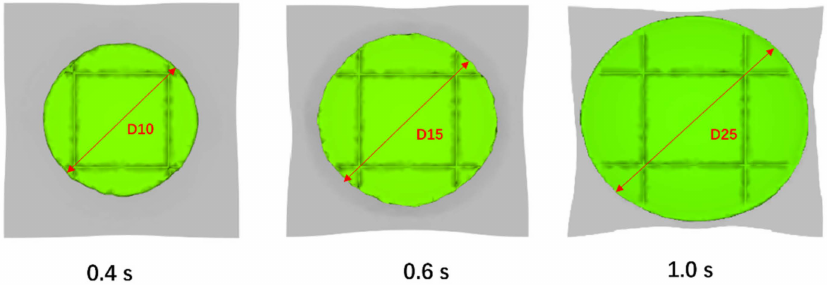
Figure 17. Top views of compression flow front at 0.4 s, 0.6 s and 1.0